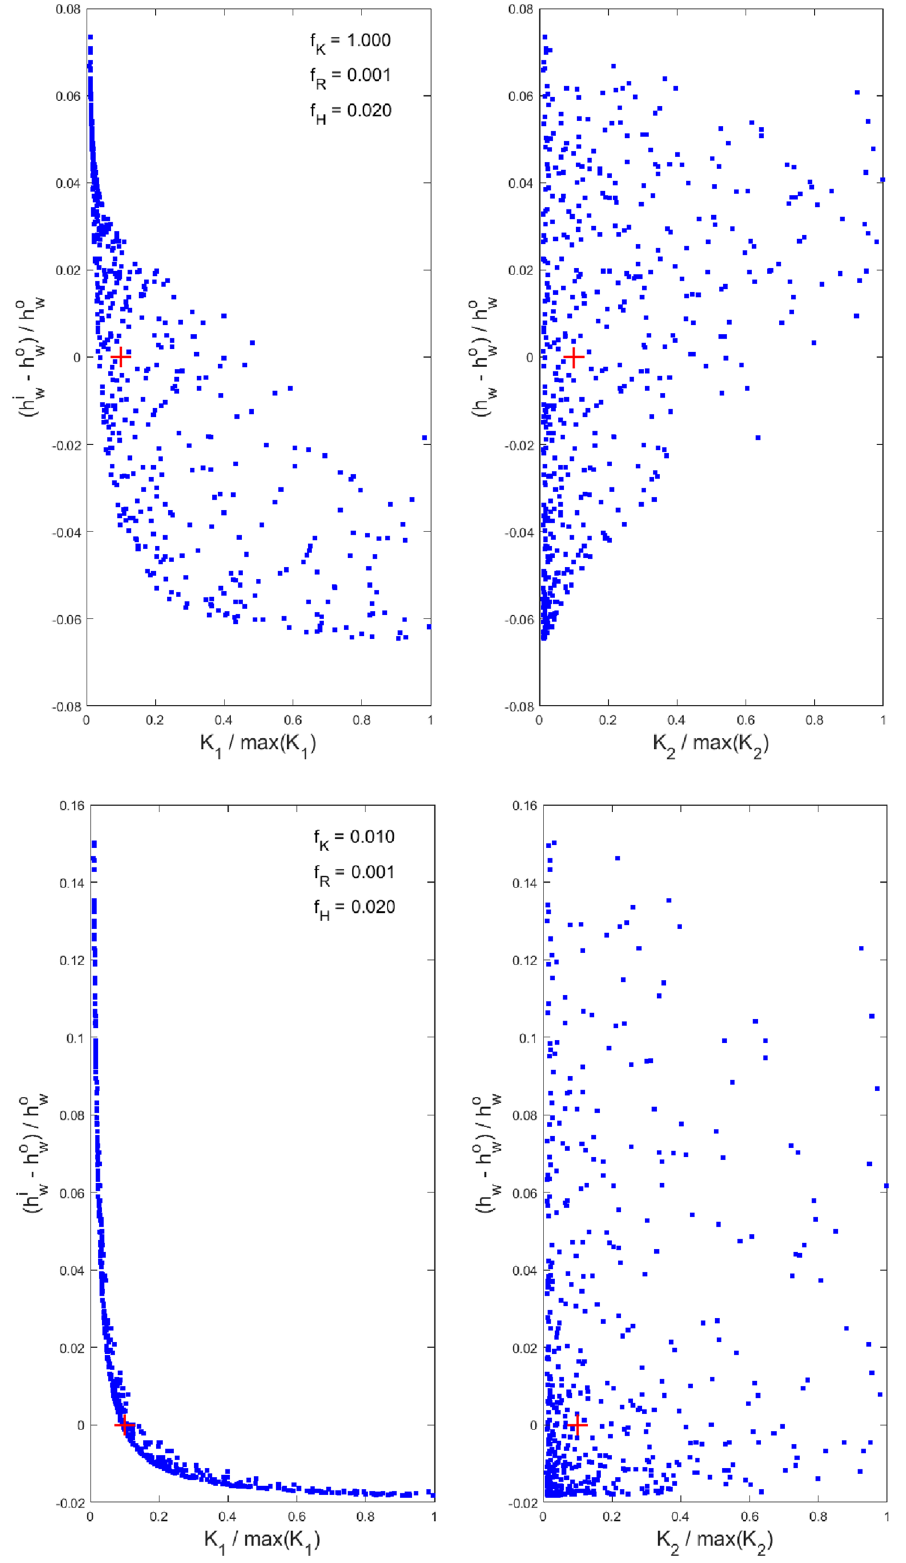
Fig. 5 Normalized residual (i.e. difference between simulated and observed head) at position of observation well versus normalized values of hydraulic conductivity for randomly generated parameter sets. Red cross indicates values for the adopted virtual reality site. a Homoge- neous and b heterogeneous